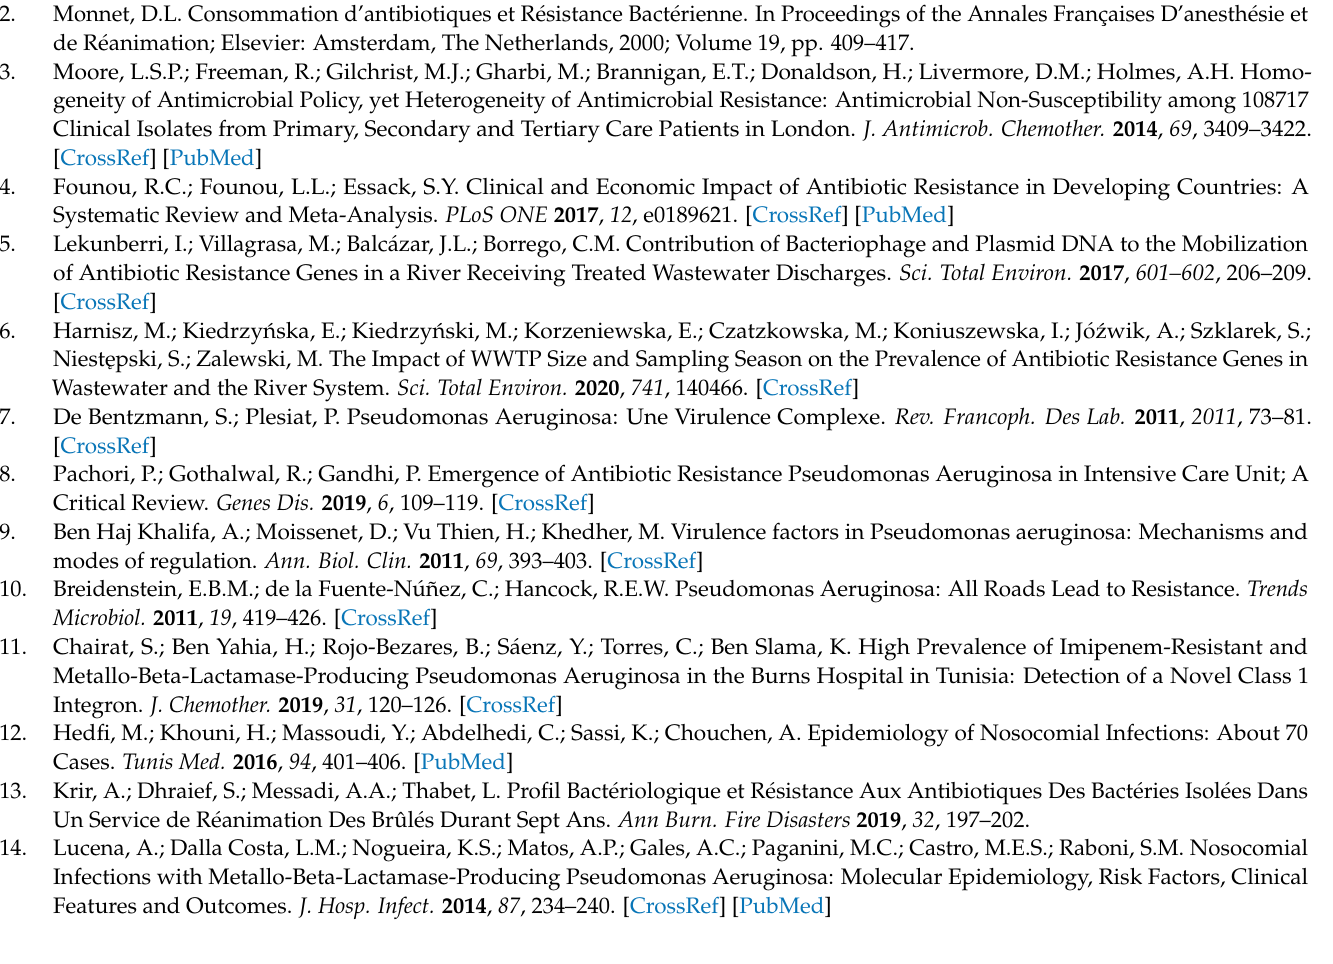
Figure S2: The adsorption curve of phages PsIn, PsCh and Ps25 on P. aeruginosa strain CN